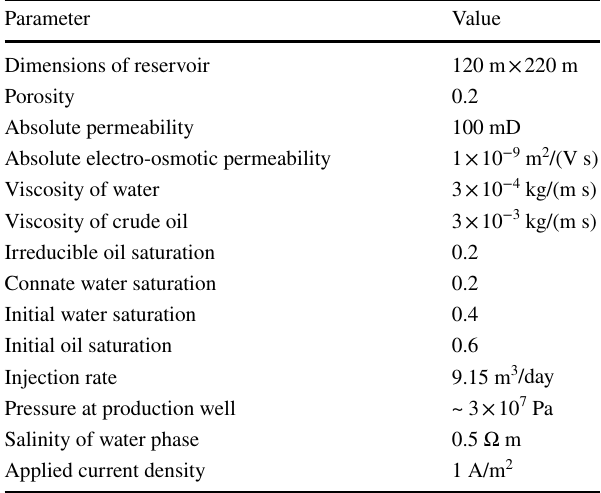
Table 1 Characteristics of reservoir used in numerical simulation